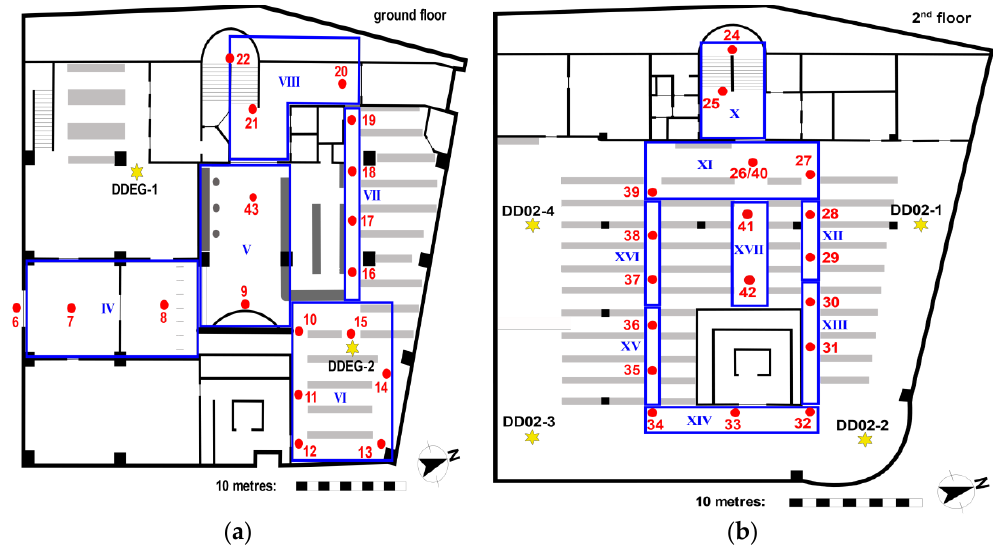
Figure 1. Ground floor ( a ) and reading room ( b ) of the library on the second floor showing the location of the APs (yellow stars), the checkpoints (red points) and the cells (blue Roman numbers). The bookshelves are represented as grey lines.